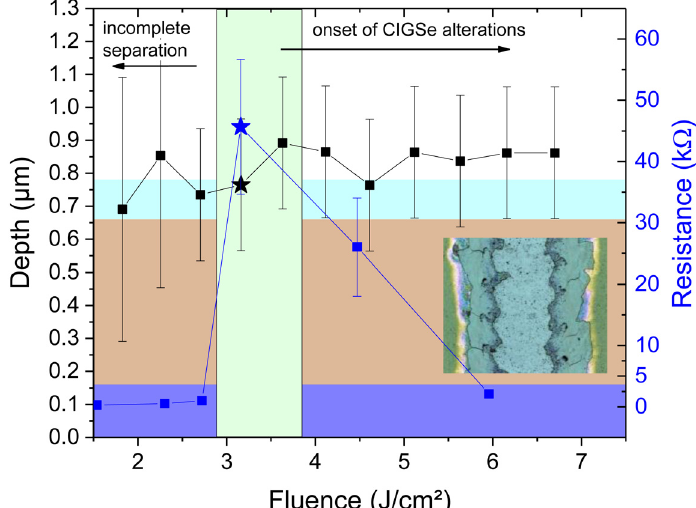
Fig. 10. P3 scribe line depth (right y -axis, black squares) and electrical resistance across the scribe line (left y -axis, blue squares) as a function of the applied laser fl uence. The range of suitable fl uences is marked by the light green area, the selected fl uence with an asterisk. The blue area corresponds to the IZO front contact, the brownish area refers to the perovskite layer, and the cyan area depicts the window layer